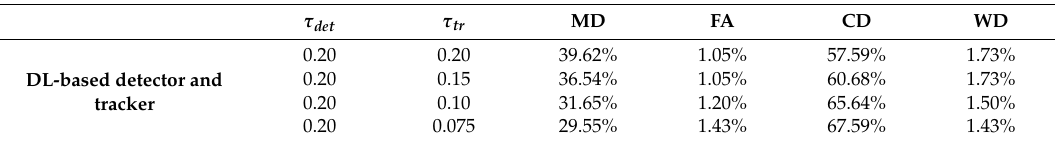
of 1330 of 1330 frames.